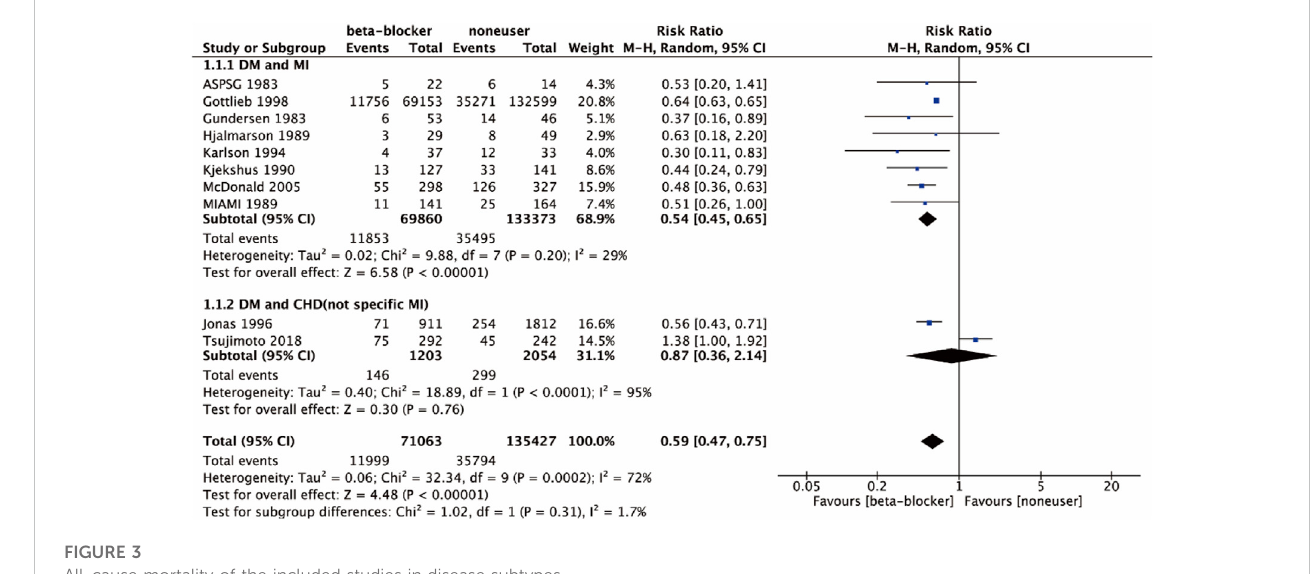
All-cause mortality of the included studies in disease subtypes.